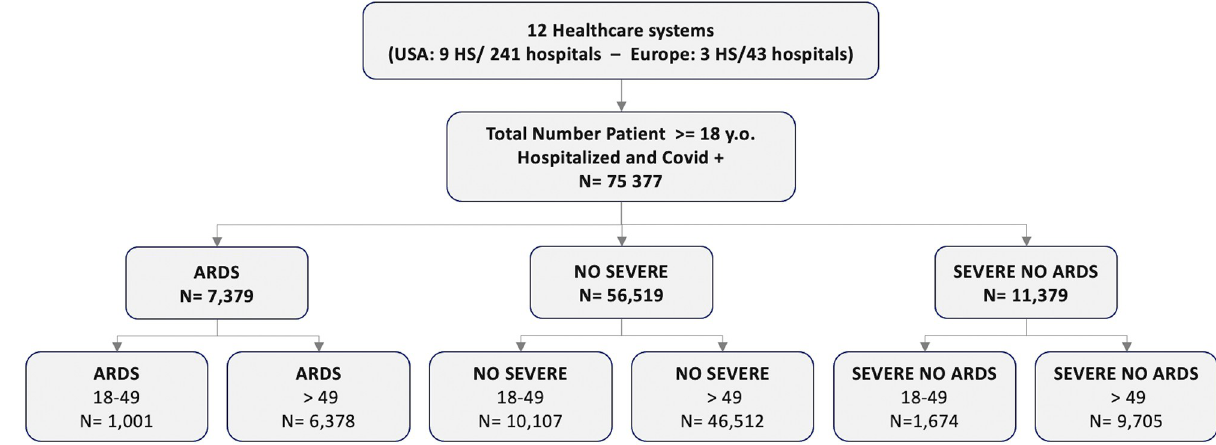
Fig 2. Flow chart. Distribution of patients per group (y.o. = years